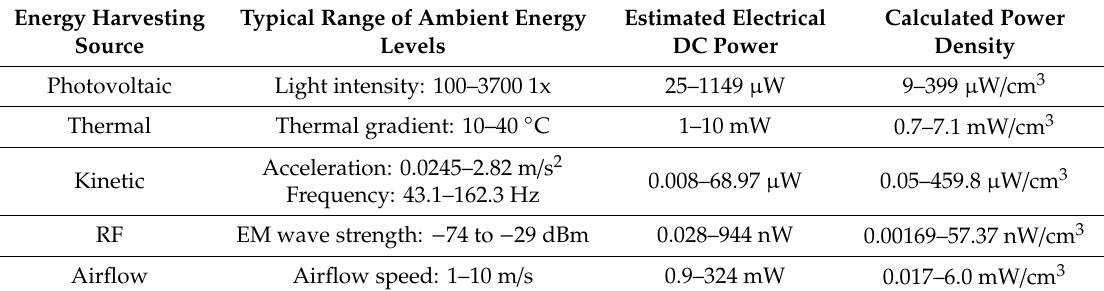
Table 6. Comparison of various commercial energy harvesting solutions available for potential use in buildings.